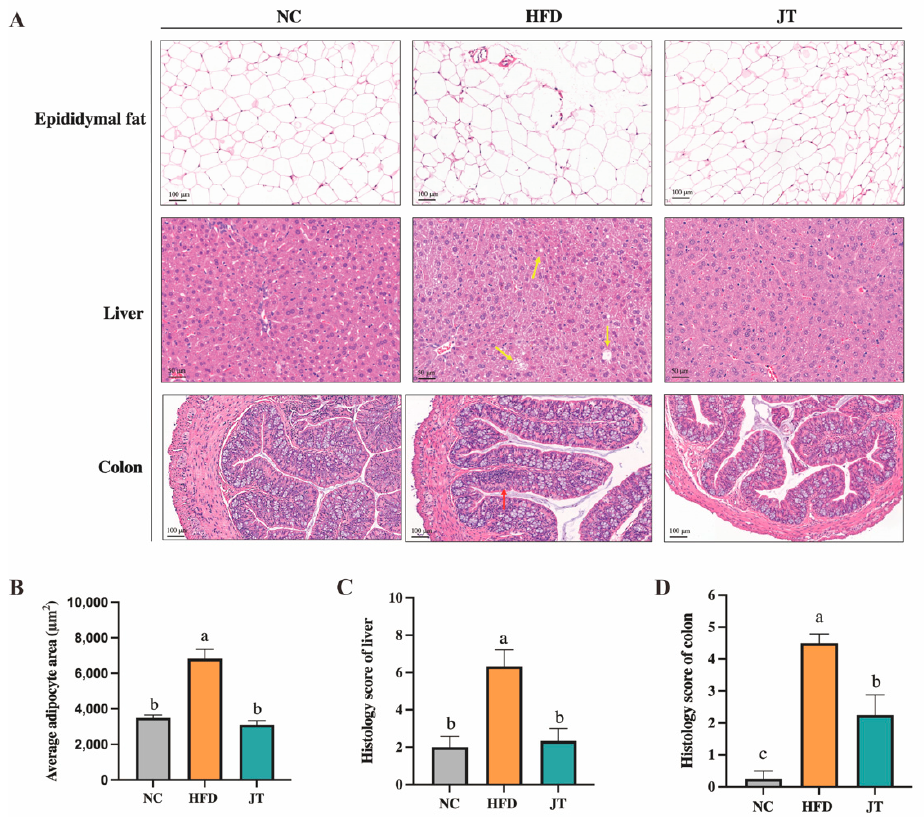
Figure 3. CB-JT attenuated HFD-induced histological injury. ( A ) Representative images of histological sections of epididymal fat, liver, and colon tissues. Yellow arrows: balloon-like structures in liver tissues; red arrows: inflammatory infiltration in colonic tissues. ( B ) Average adipocyte area of epididymis adipose. ( C ) Histology score of liver. ( D ) Histology score of colon tissues. NC: normal- chow group, HFD: high-fat diet group, JT: jasmine tea group. Data are expressed as the mean ± SEM. The mean value with different letters indicates significant differences ( p < 0.05).